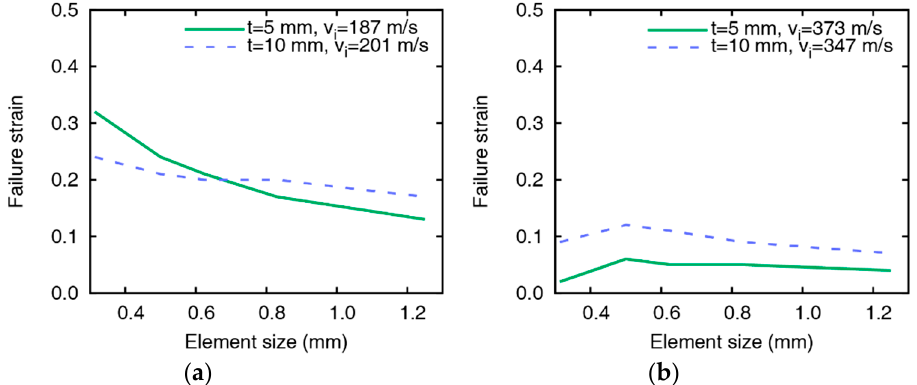
Figure 8. Comparison of failure strains at similar impact velocities for the plates of thicknesses 5 mm and 10 mm. Failure strins by ( a ) impact velocities at 187.4 and 200.9 m/s and ( b ) impact velocities at 346.8 and 372.8 m/s.